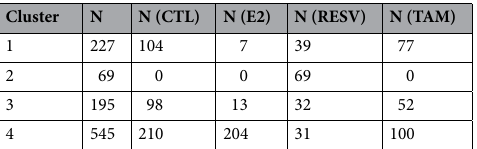
Table 2. Analysis of the four cluster with respect to kind of treatment.